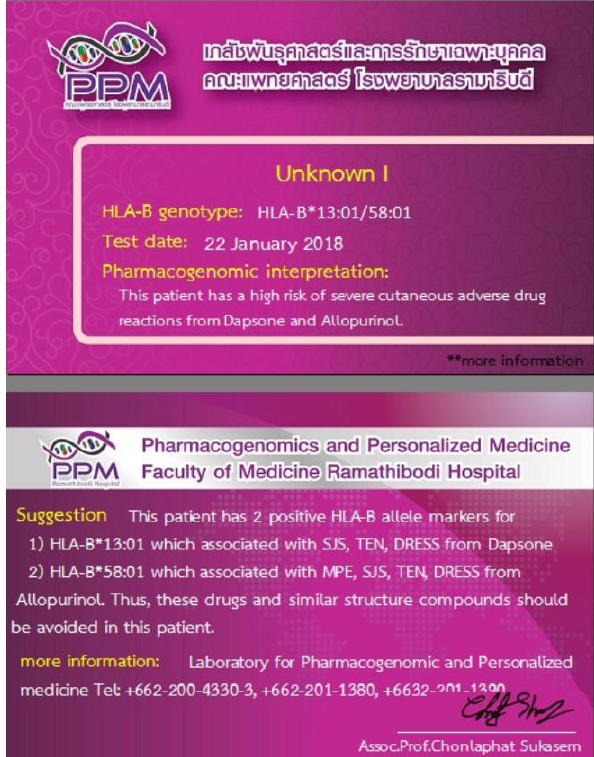
Figure 3. The pharmacogenetic card as part of pharmacogenetic implementation practice in Thailand. Patients’ pharmacogenetic information is entered into the pharmacogenetic card, a purple rectangle and wallet-sized card that they carry around and show to their future healthcare providers, such as physicians and pharmacists.